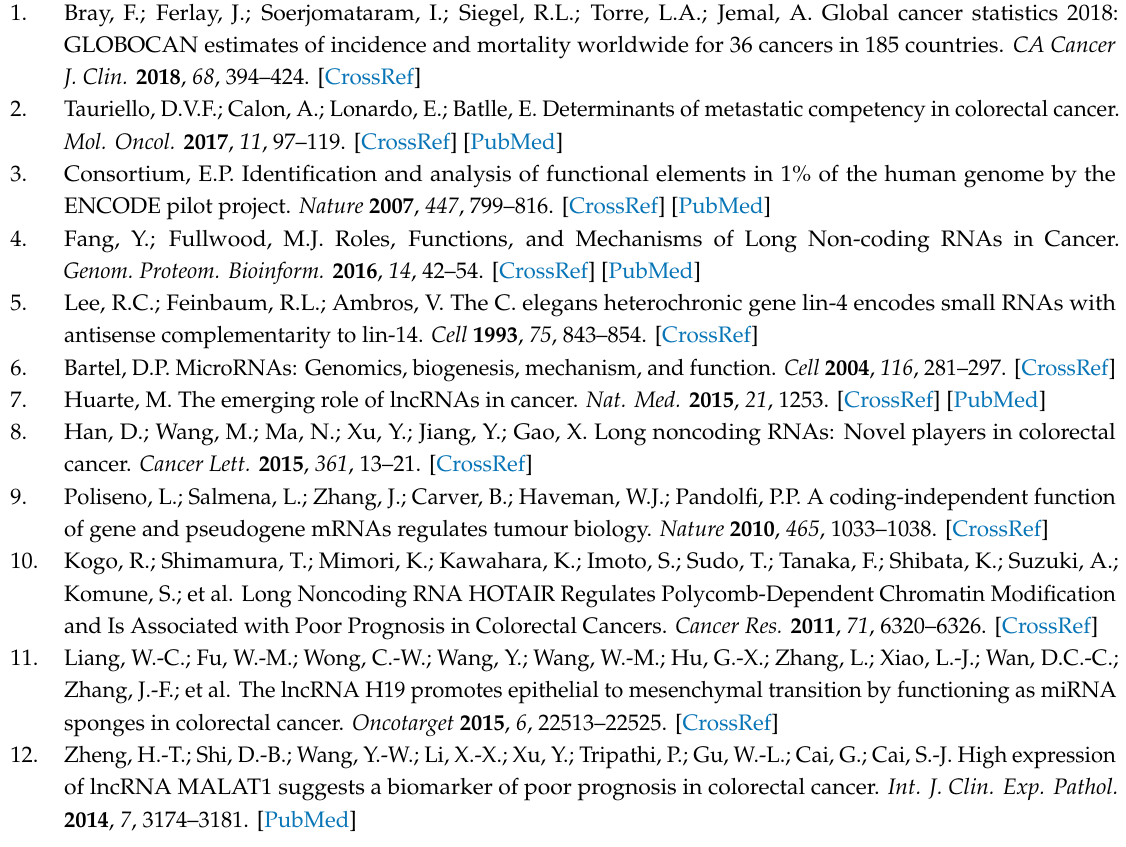
Table S4: Metastasis CRC specific DE lncRNAs in ceRNA network; Table S5: Clinical covariates in the training and testing sets; Table S6: 3-lncRNA risk score model; Table S7: The top 200 mRNAs co-expressed with LINC00261 and